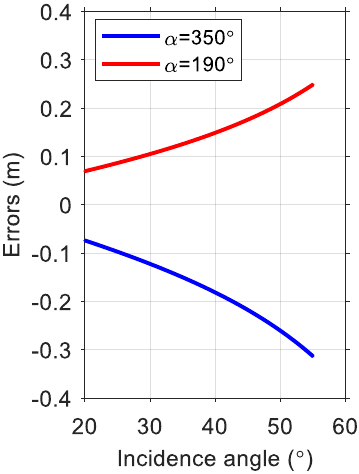
Figure 8. Relationship of the errors of the NOV-estimated subsidence with respect to coherence ( 0.1~1.0 =